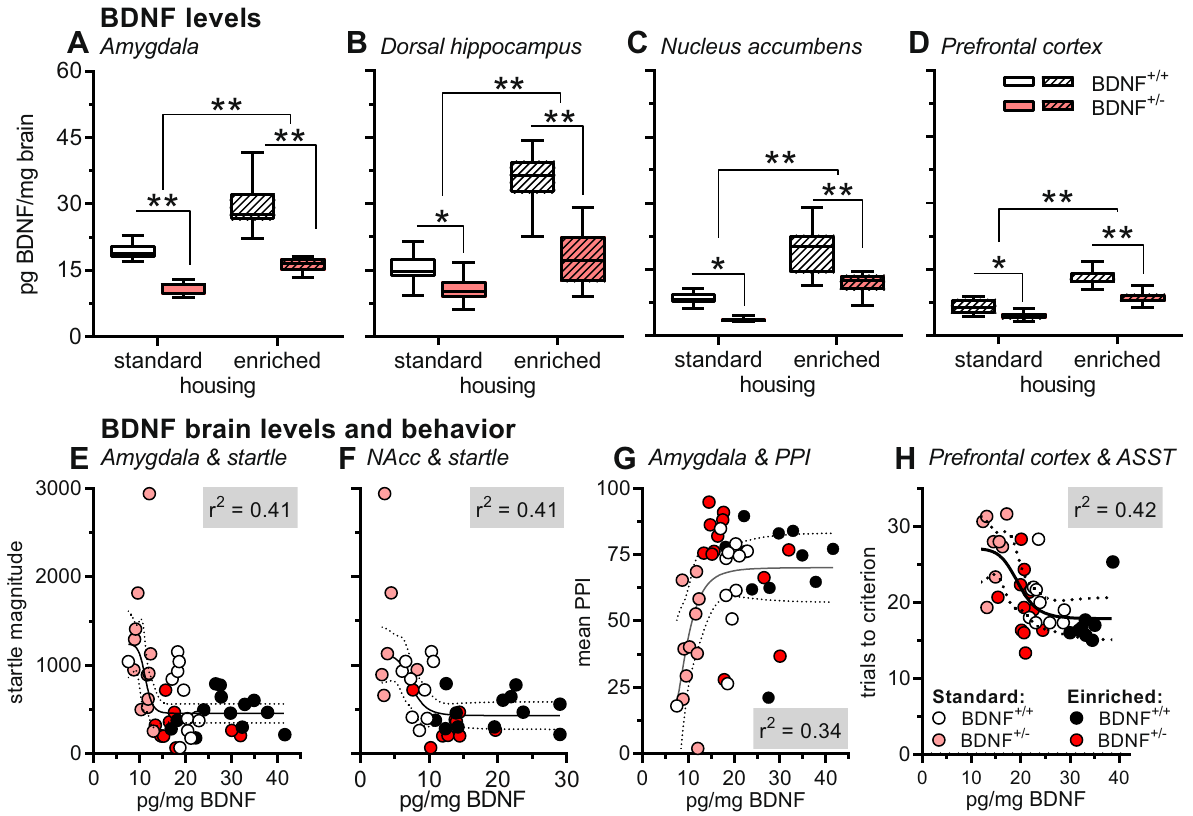
Fig. 5 BDNF brain levels were generally decreased in BDNF + / − mice, irrespective of housing condition. Exposure to enriched environment increased BDNF levels in both genotypes. Of note, BDNF + / − mice previously housed in enriched environment had similar BDNF levels than standard- housed BDNF + / + mice. This increase of BDNF brain levels in BDNF + / − mice by enriched environment was associated with the rescue of behavioral de fi cits observed after standard housing. In wild-type mice, enriched environment increased BDNF brain levels but did not affect behavior. A , D Mean BDNF levels measured two weeks after the end of the behavioral experiments in the amygdala ( A ), dorsal hippocampus ( B ), nucleus accumbens ( C ), and prefrontal cortex ( D ). ** P < 0.01, * P < 0.05, main effects in ANOVA or post hoc comparisons as indicated. E – H In some brain areas, individual BDNF brain levels were correlated with individual behavioral performance. We generally found that sigmoid regression curves best fi tted the results. Depicted are the cases with r 2 -values >0.34. For example, higher BDNF levels in the amygdala and nucleus accumbens (NAcc) were associated with decreased startle magnitudes ( E , F ). In addition, PPI was increased with higher amygdaloid BDNF levels ( G ). In the ASST, the trials to criterion were reduced with higher BDNF levels in the prefrontal cortex ( H ). Group sizes (standard/BDNF + / + , standard/BDNF + / − , enriched/BDNF + / + , 8 enriched/ BDNF + / − ): amygdala: 13, 13, 18, 8; dorsal hippocampus: 13, 13, 17, 11; nucleus accumbens: 11, 6, 15, 11; frontal cortex: 10, 8, 8,